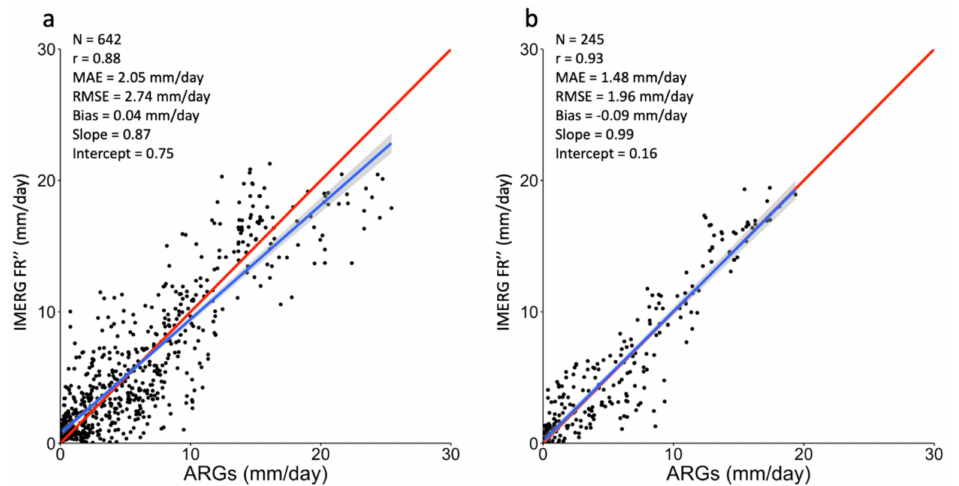
Figure 12. Performance of bias-corrected IMERG FR compared to ARG rainfall at ( a ) 10 day and ( b ) monthly timescales. Slope of the regression line (blue) becomes much closer to the perfect agreement line